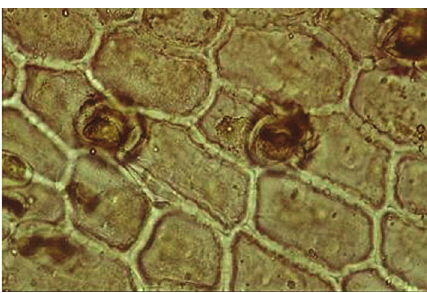
Figure 2: Tissue sample from Werneria